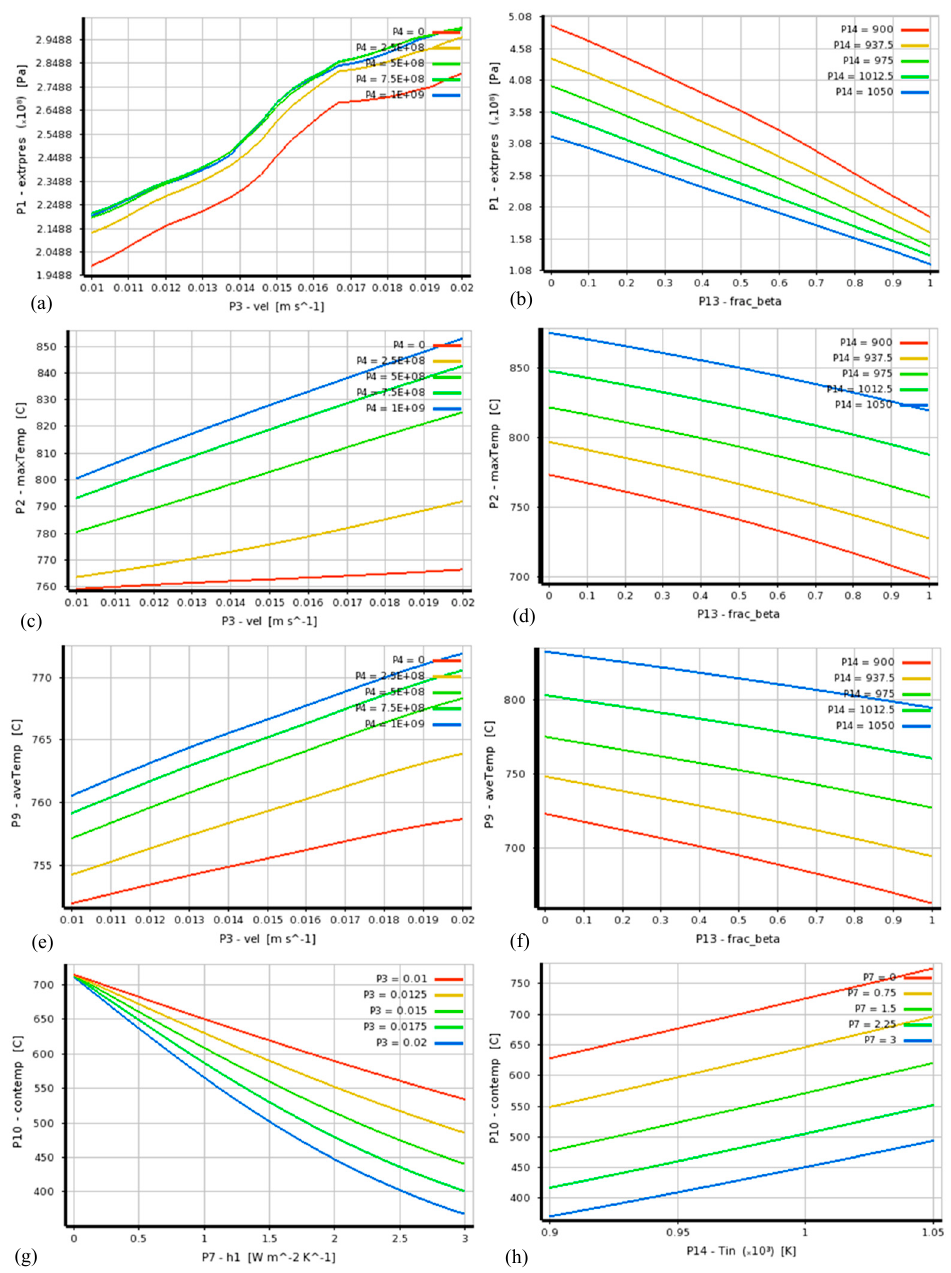
Figure 8. Process charts showing the dependence of the process output parameters on the input parameters. ( a ) Extrusion pressure ( P 1) vs. extrusion speed ( S ). ( b ) Extrusion pressure ( P 1) vs. β -phase fraction ( f β ). ( c ) Max. extrusion temperature ( P 2) vs. extrusion speed ( S ). ( d ) Max. extrusion temperature ( P 2) vs. β -phase fraction ( f β ). ( e ) Average extrusion temperature ( P 9) vs. extrusion speed ( S ). ( f ) Average extrusion temperature ( P 9) vs. β -phase fraction ( f β ). ( g ) Container temperature ( P 10) vs. heat transfer coefficient ( h ). ( h ) Container temperature ( P 10) vs. inlet temperature ( T in ). The input parameters have the default values: f = 5 × 10 8 Ns/m 3 , S = 1.5 cm/s, f β = 0.5, T in = 715 °C, h = 1.7 W/(m 2 K), unless otherwise stated by each chart.